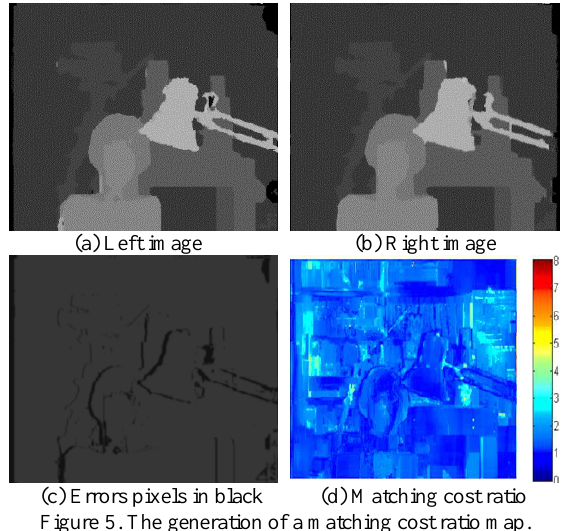
Figure 5. The generation of a matching cost ratio